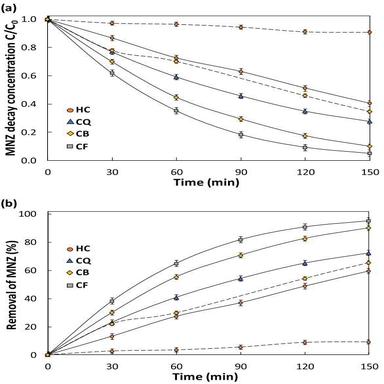
Degradation kinetics of metronidazole (MNZ) by AO (dashed lines) and EF (solid lines) treatments using different carbon materials as cathodes; BDD as anode, 0.05 M Na2SO4 electrolyte, 100 mg L− 1 of metronidazole, applied potential − 0.75 V vs Ag/AgCl. Experimental data is shown as: (a) relative decay concentration of metronidazole, and (b) removal percentage.